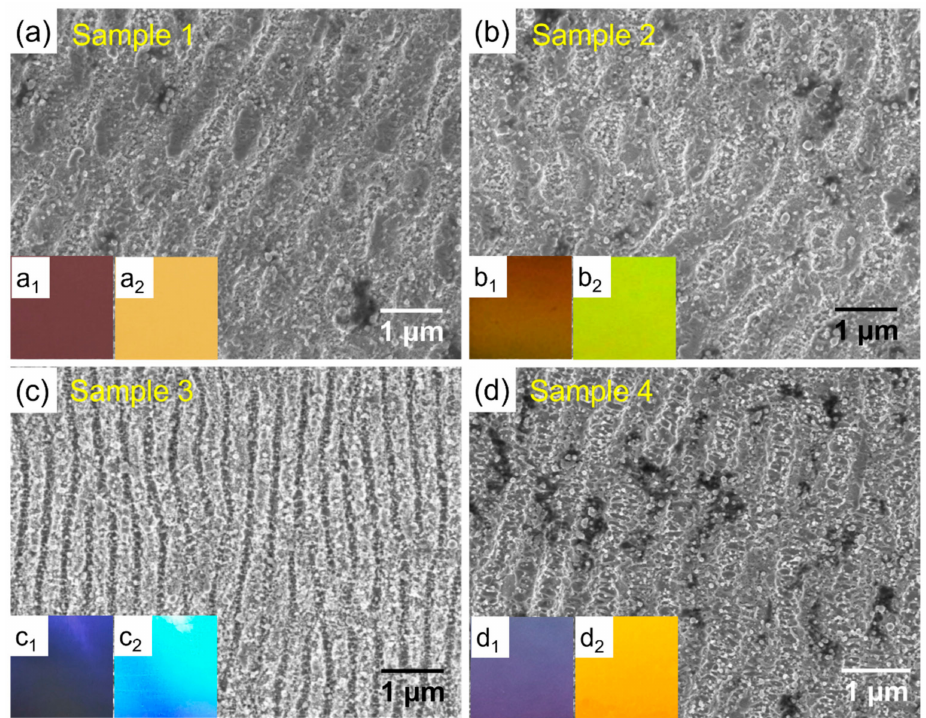
Figure 1. Morphologies and angle-dependent appearances of laser-marked steel surfaces. ( a – d ) SEM images of the Samples 1–4, and the insets in each panel are optical photos taken at the angles of 30 and 70 degrees,